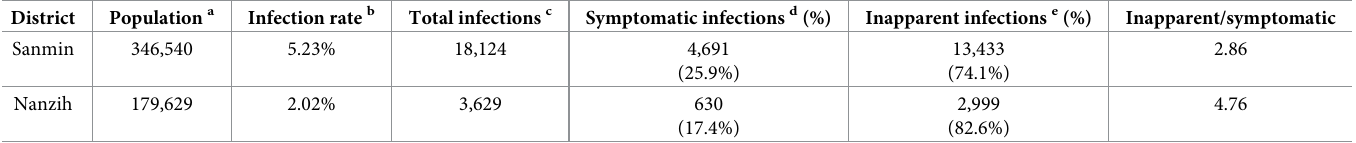
Table 2. Ratio of inapparent to symptomatic DENV infections during the 2015 outbreak in Kaohsiung